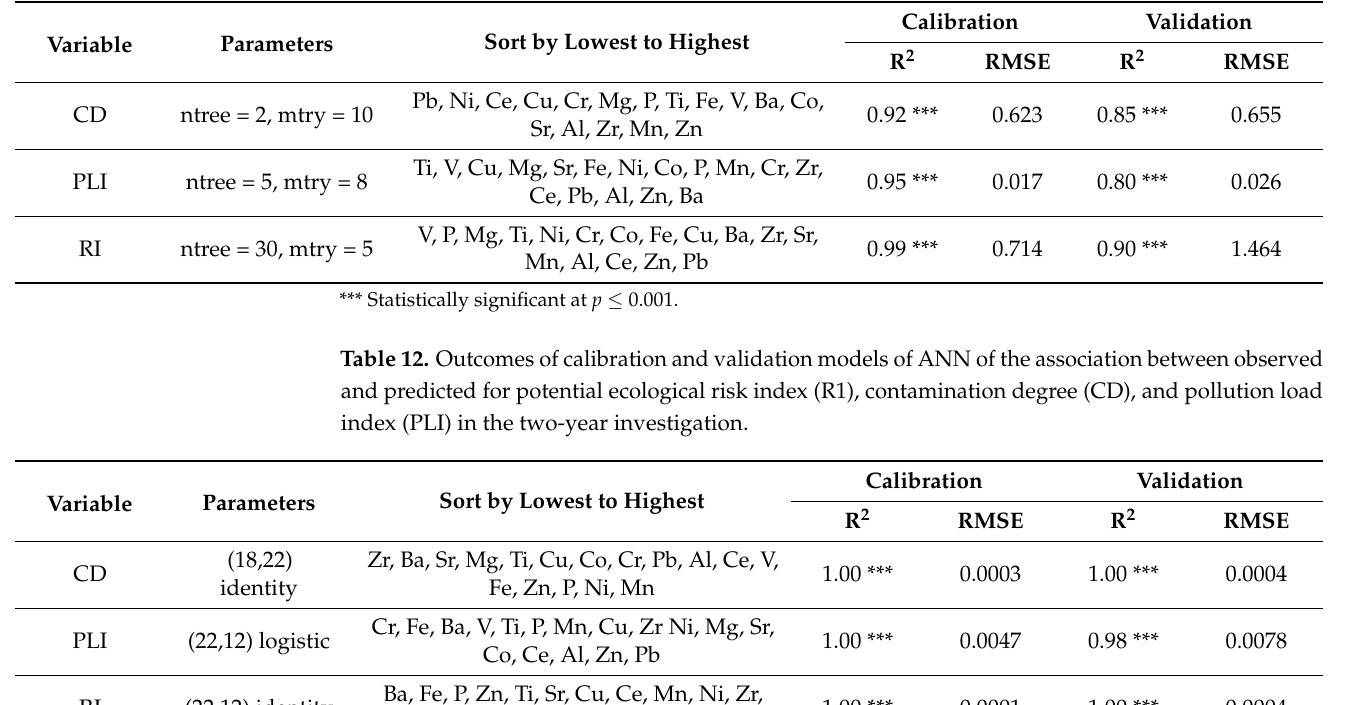
Table 11. Results of validation models of random forest of the association between observed and predicted of degree of contamination (CD), pollution load index (PLI), and potential ecological risk index (R1) in two years.